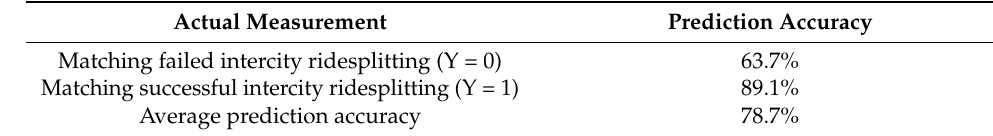
Table 4. Prediction results of the Yinchuan